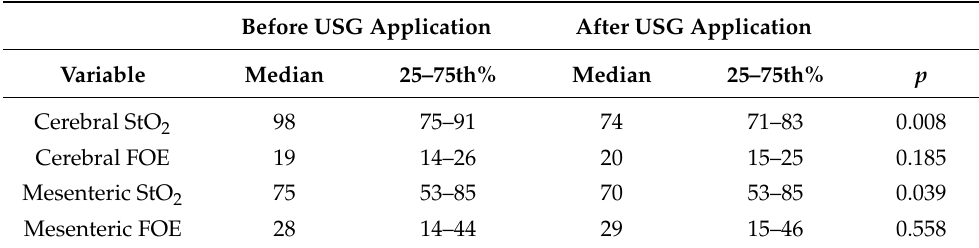
Table 3. NIRS measurements, calculated FOE of the patients. Abbreviations: StO 2 : tissue oxygen saturation, FOE: fractional oxygen